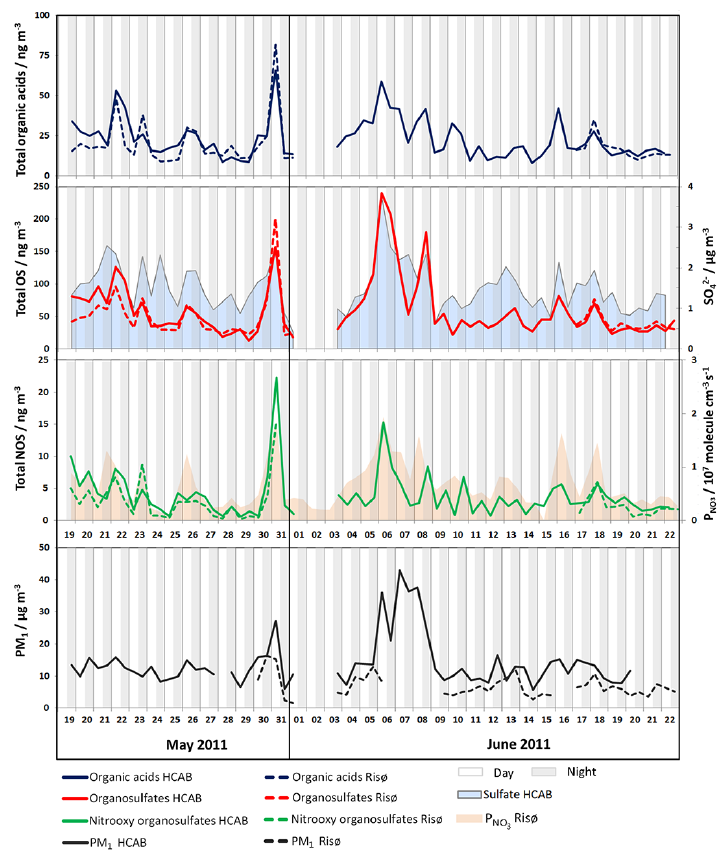
Figure 3. Temporal trends of total concentrations of organic acids, organosulfates, nitrooxy organosulfates and PM 1 at the urban curbside site HCAB (solid line) and the semi-rural background site Risø (dashed line). The figure shows a strong correlation between the two sites and among the three categories of compounds examined. Sulfate (HCAB) and production rate of NO 3 radical (Risø) are also shown in the organosulfate and nitrooxy organosulfate panels,